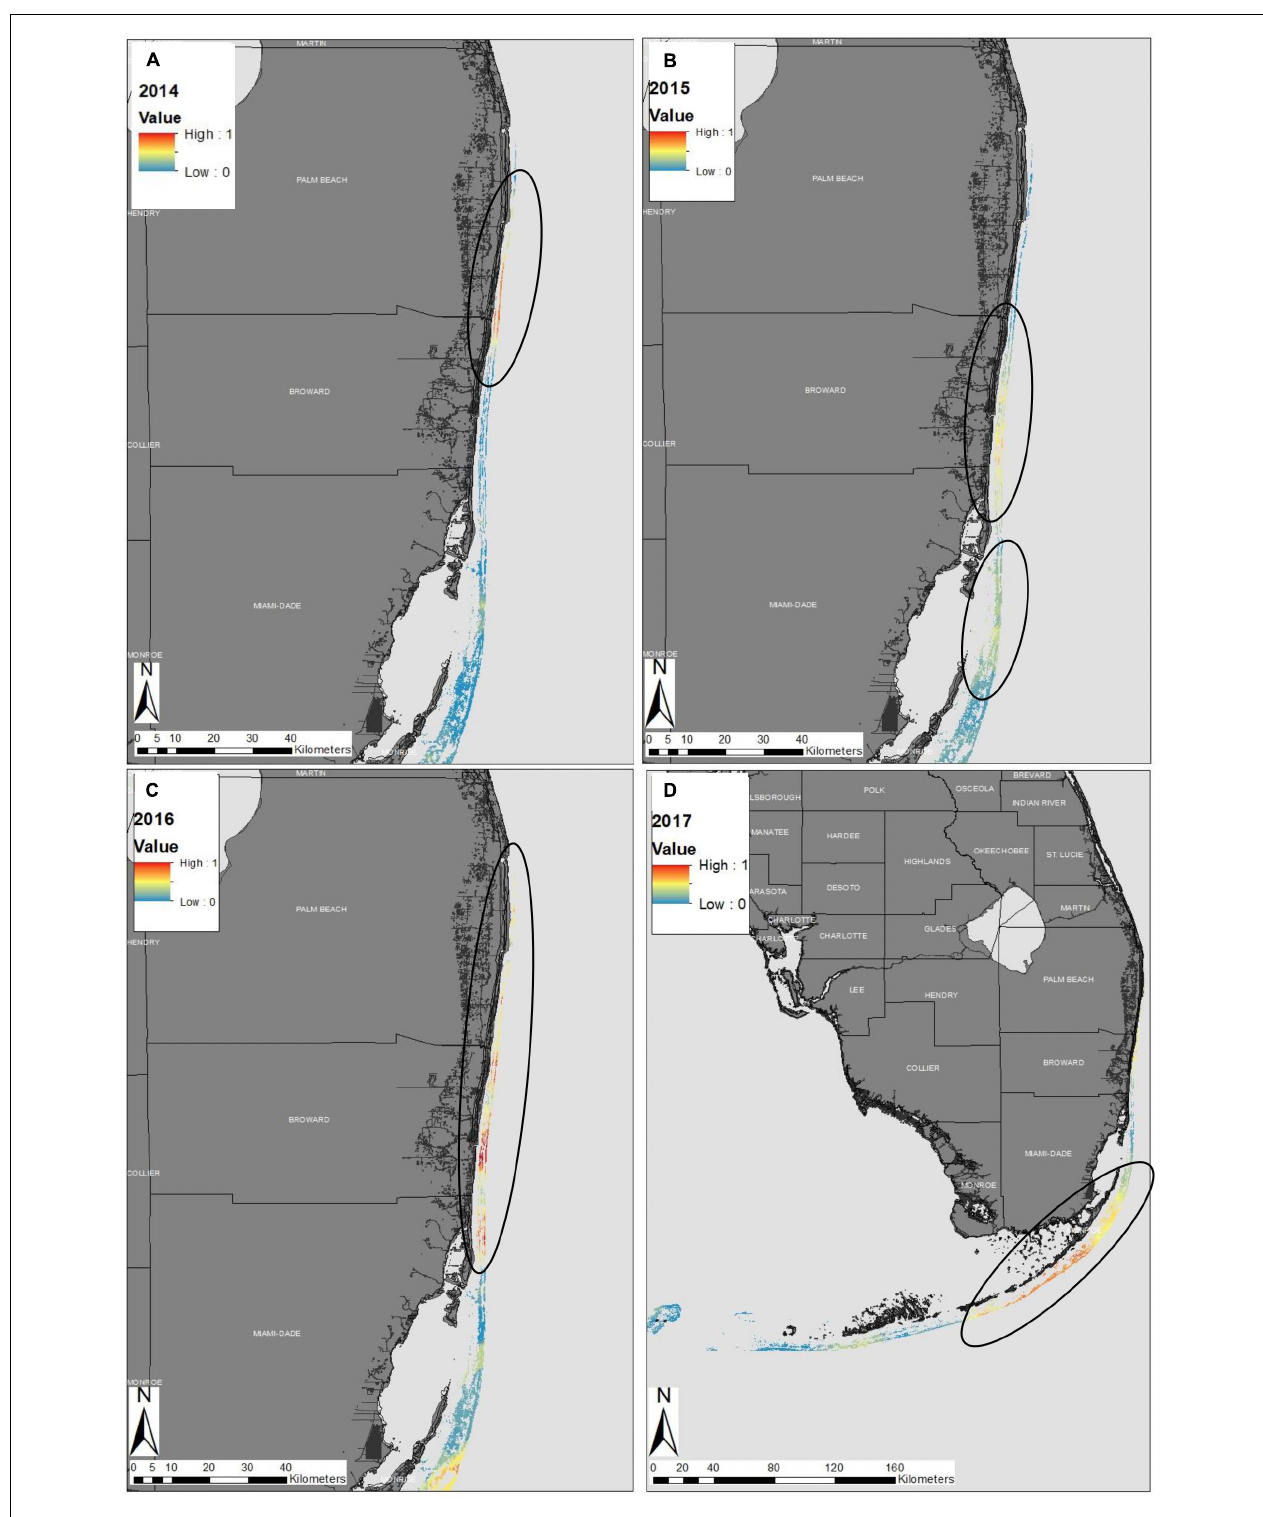
FIGURE 2 | Epidemiological probability maps of the stony-coral-tissue-loss disease outbreak in southeastern Florida in (A) 2014, (B) 2015, (C) 2016, and (D) throughout the entire Florida reef tract in 2017. Colors along the reef denote the probability of disease presence within the Florida reef tract. Warm colors represent high probability of the stony-coral-tissue loss-disease and cool colors represent low disease probability. Black circles represent ‘hotspots’ within the reef discussed within the text. The disease probability map was created using indicator kriging in ArcGIS software.